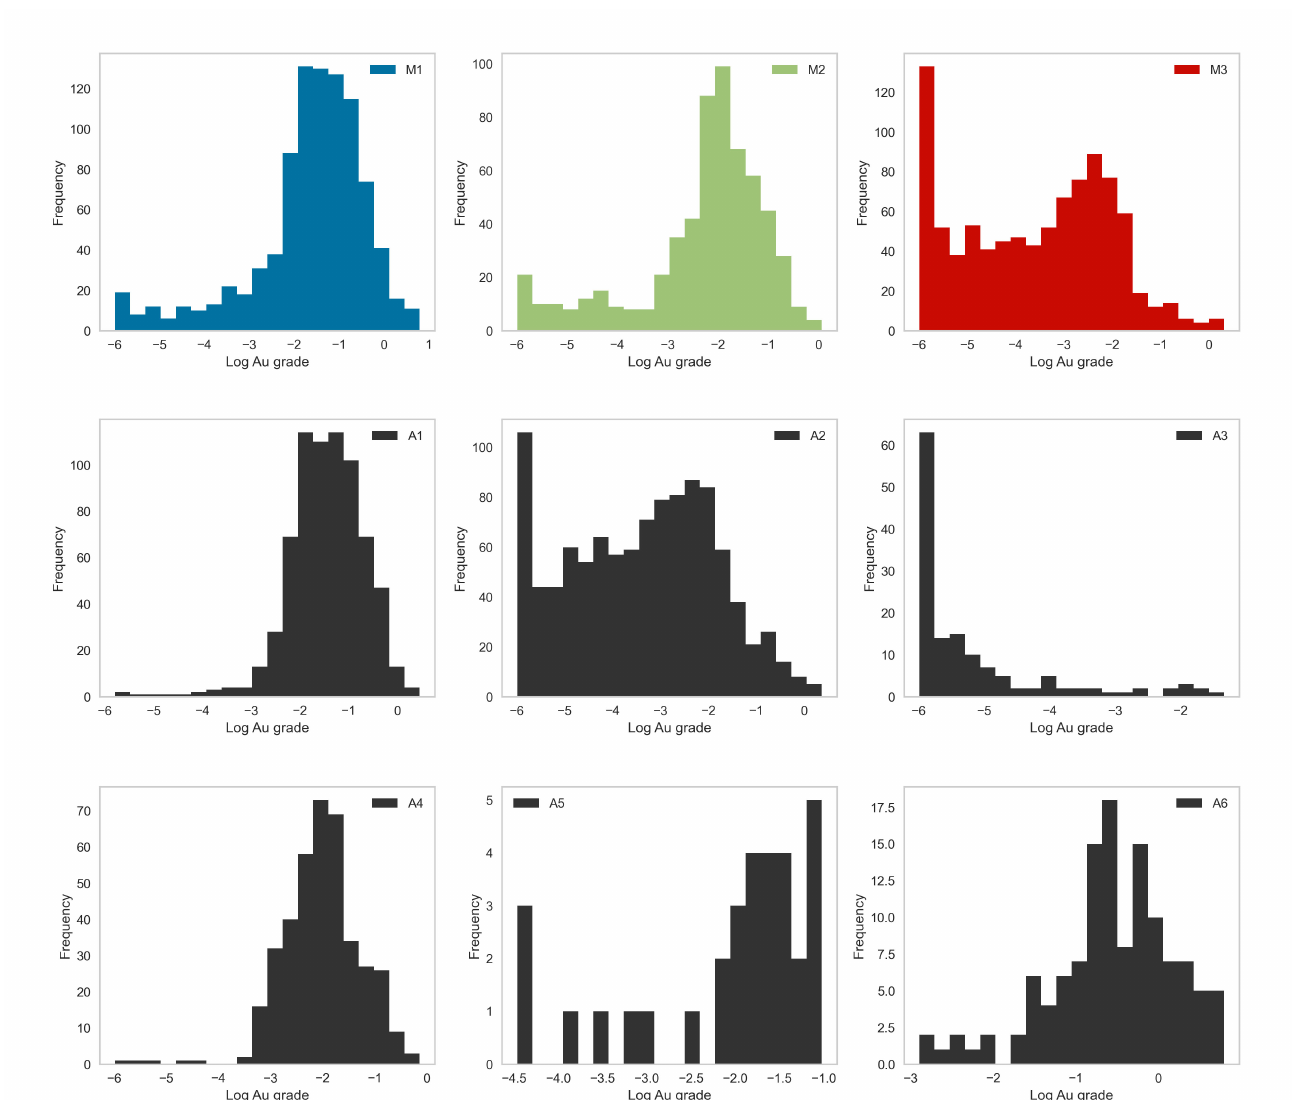
Figure 4. Simple log-normal Au grade histogram by mineral zone and type of alteration.